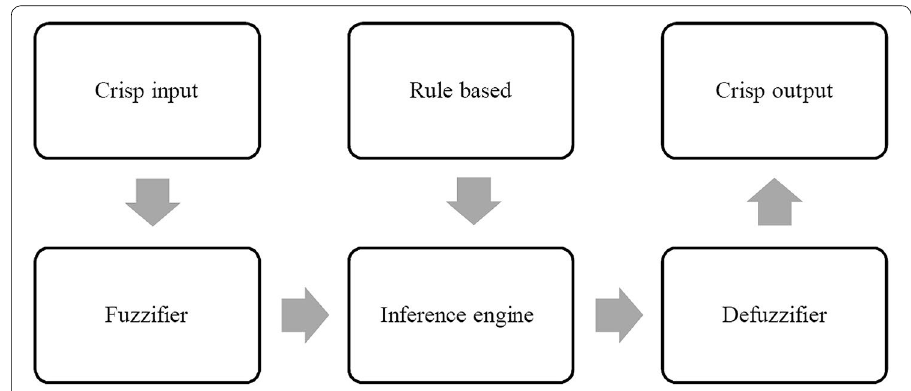
Fig. 1 Fundamental units of fuzzy inference